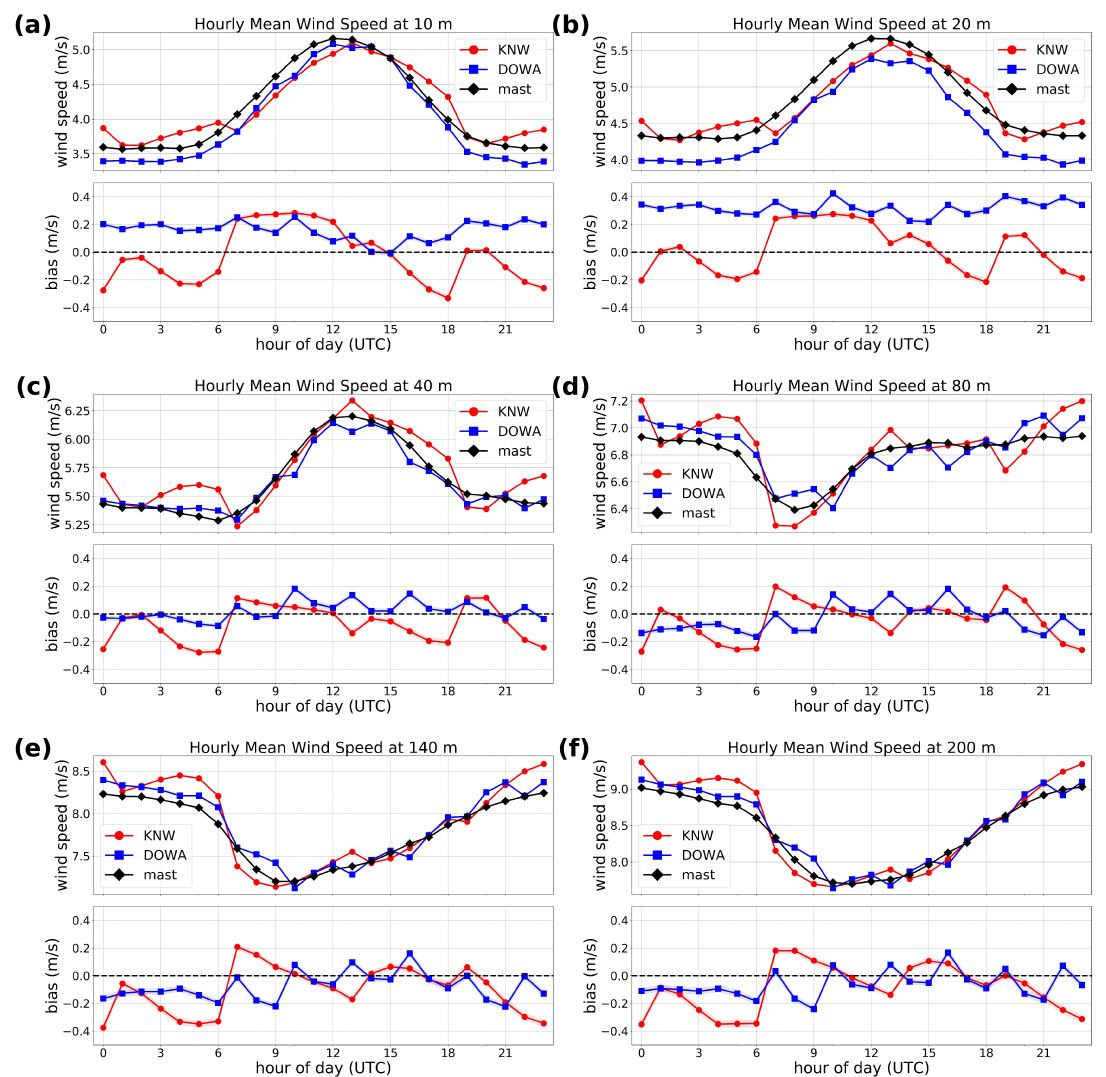
Figure 6. Hourly mean wind speed at ( a ) 10 m, ( b ) 20 m, ( c ) 40 m, ( d ) 80 m, ( e ) 140 m, and ( f ) 200 m, showing mast measurements (black), DOWA (blue), and KNW atlas (red). The upper panel shows the wind speed of both mast measurements and models, and the lower panel the bias (measurement minus model) between the mast measurements and the